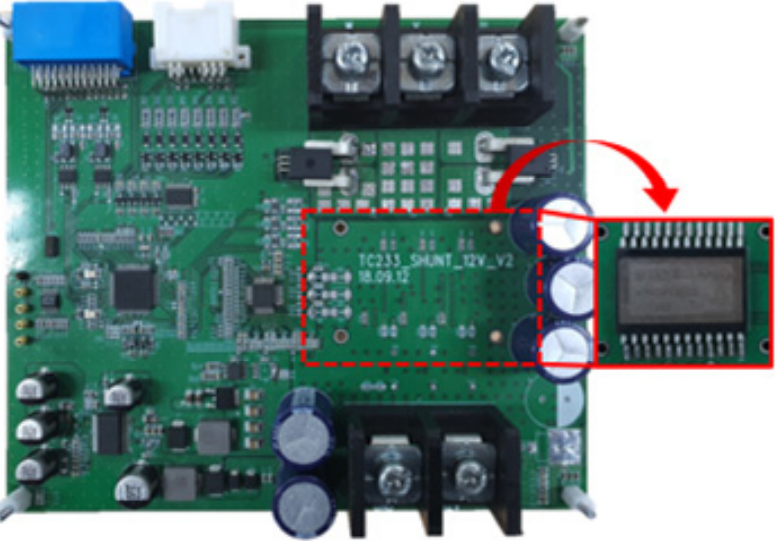
Figure 8. Inverter for development using MOSFET (MT145WX100GD).